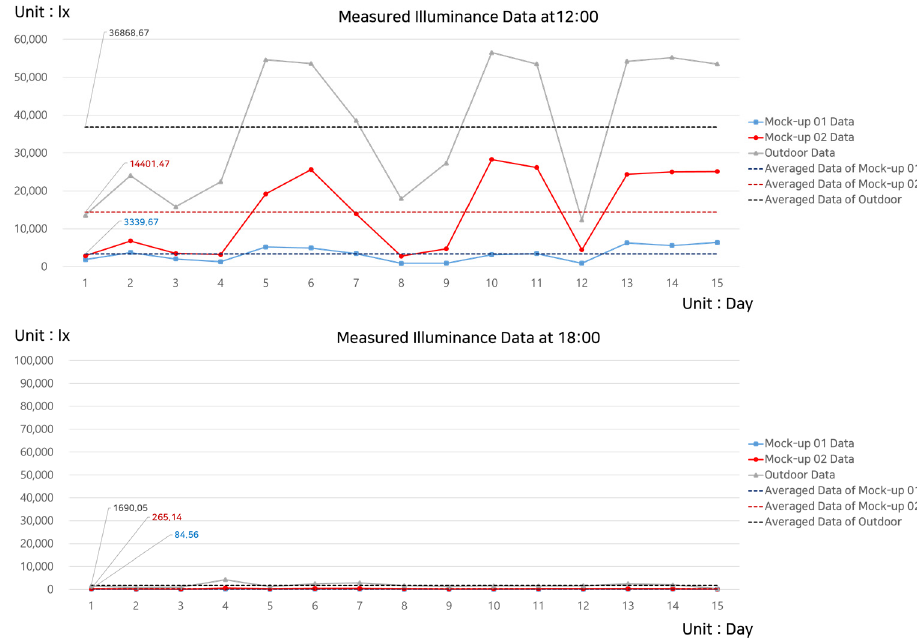
Figure 11. Measured illuminance data in autumn season.